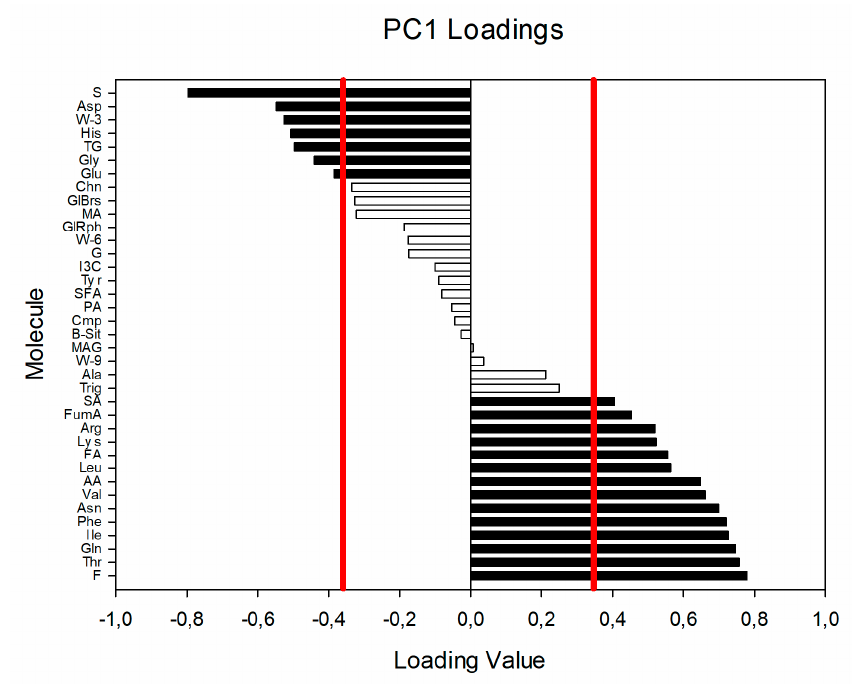
Figure 2. Normalized PC1 loading values. The red lined indicate the significance threshold and in black the variables with p < 0.05 are evidenced.